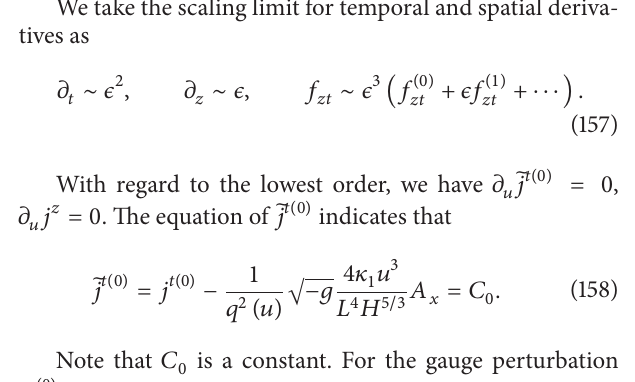
Figure 3: The DC charge conductivity as a function of the radial coordinate 𝑢 . The dashed line represents the zero charge